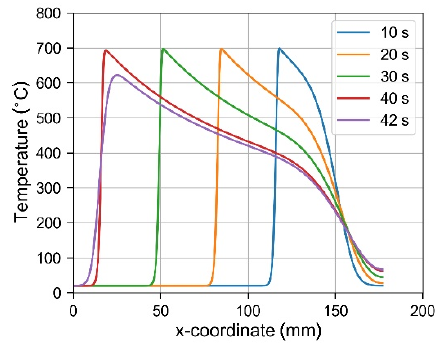
Figure 9. Temperature profiles along the axis of the beam (y = 0, z = 0.5) at selected time instants during laser heating and cooling.